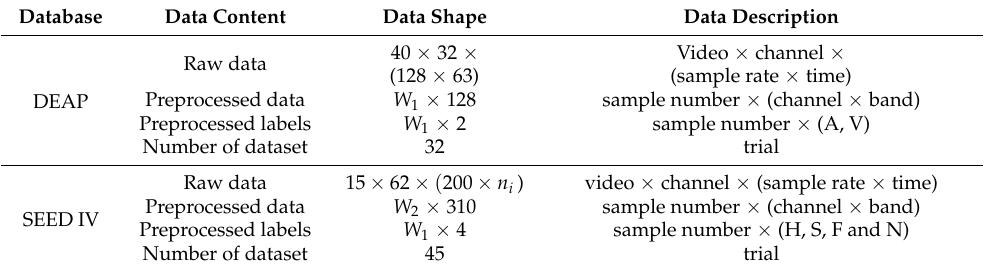
Table 1. The details of the pre-processed database. (Arousal and valence are represented by A and V, respectively; happy, sad, fear, and neutral are represented by H, S, F and N, respectively.)